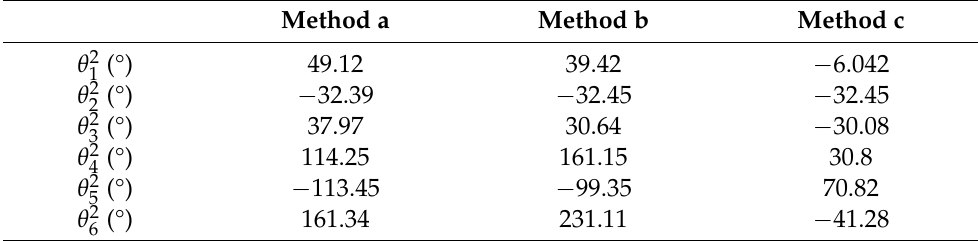
Table 7. The maximum joint angular velocity components of Arm-2 in three comparing